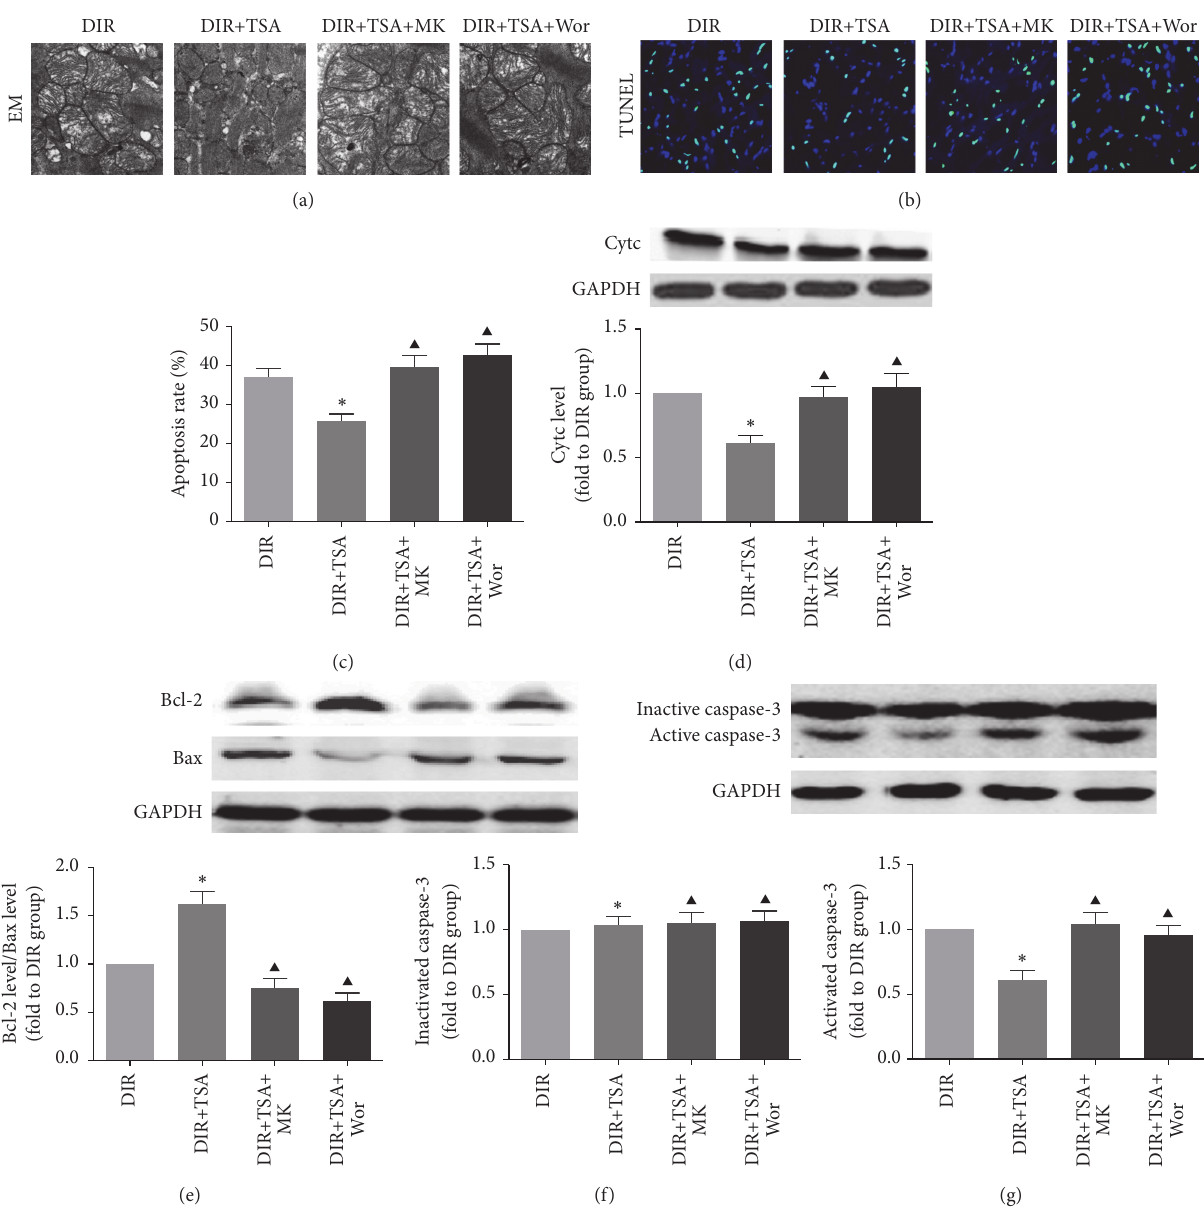
Figure 4: HDAC inhibition attenuated mitochondria-associated apoptosis in diabetic rats. (a) Representative electron micrographs of each group ( × 7000). (b) Representative TUNEL staining images of each group. (c) Quantitative analysis of the apoptosis rate in each group. (d, e) Representative immune blot images and assessment of the cytochrome C (cytc), Bcl-2, and Bax level in each group. (f, g) Representative immune blot images and assessment of activated and inactivated caspase-3 in cardiac tissue. All results are presented as the mean ± SEM, 𝑛 = 6 /group. ∗ 𝑝 < 0.05 versus DIR group. 󳵳 𝑝 < 0.05 versus DIR+TSA